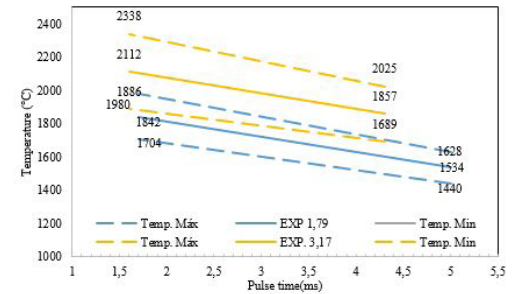
Figure 10. Weld pool temperature versus Pulse time.